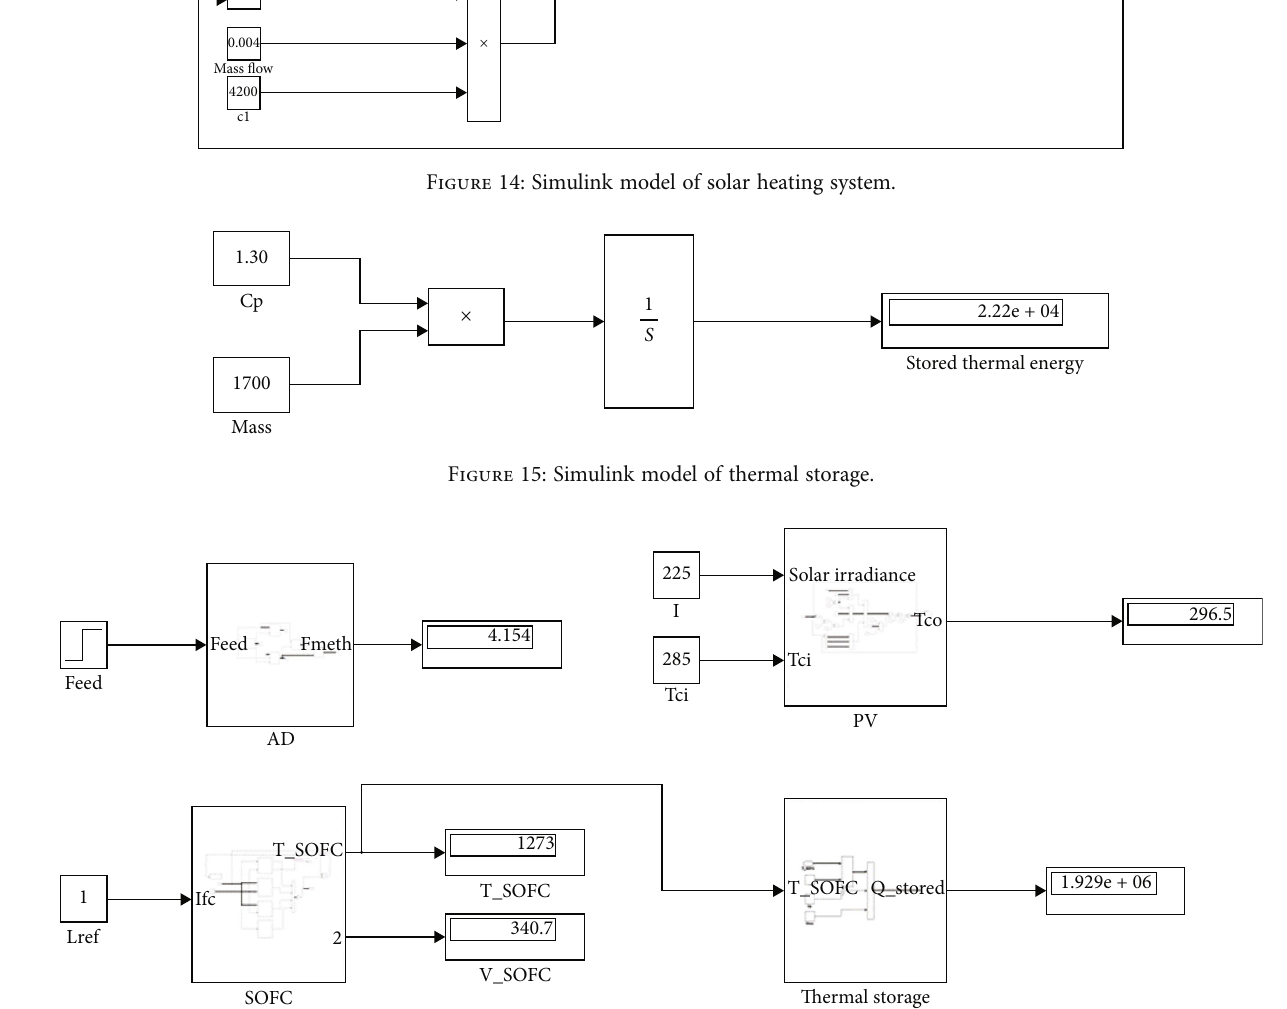
Figure 16: Simulink model of the proposed